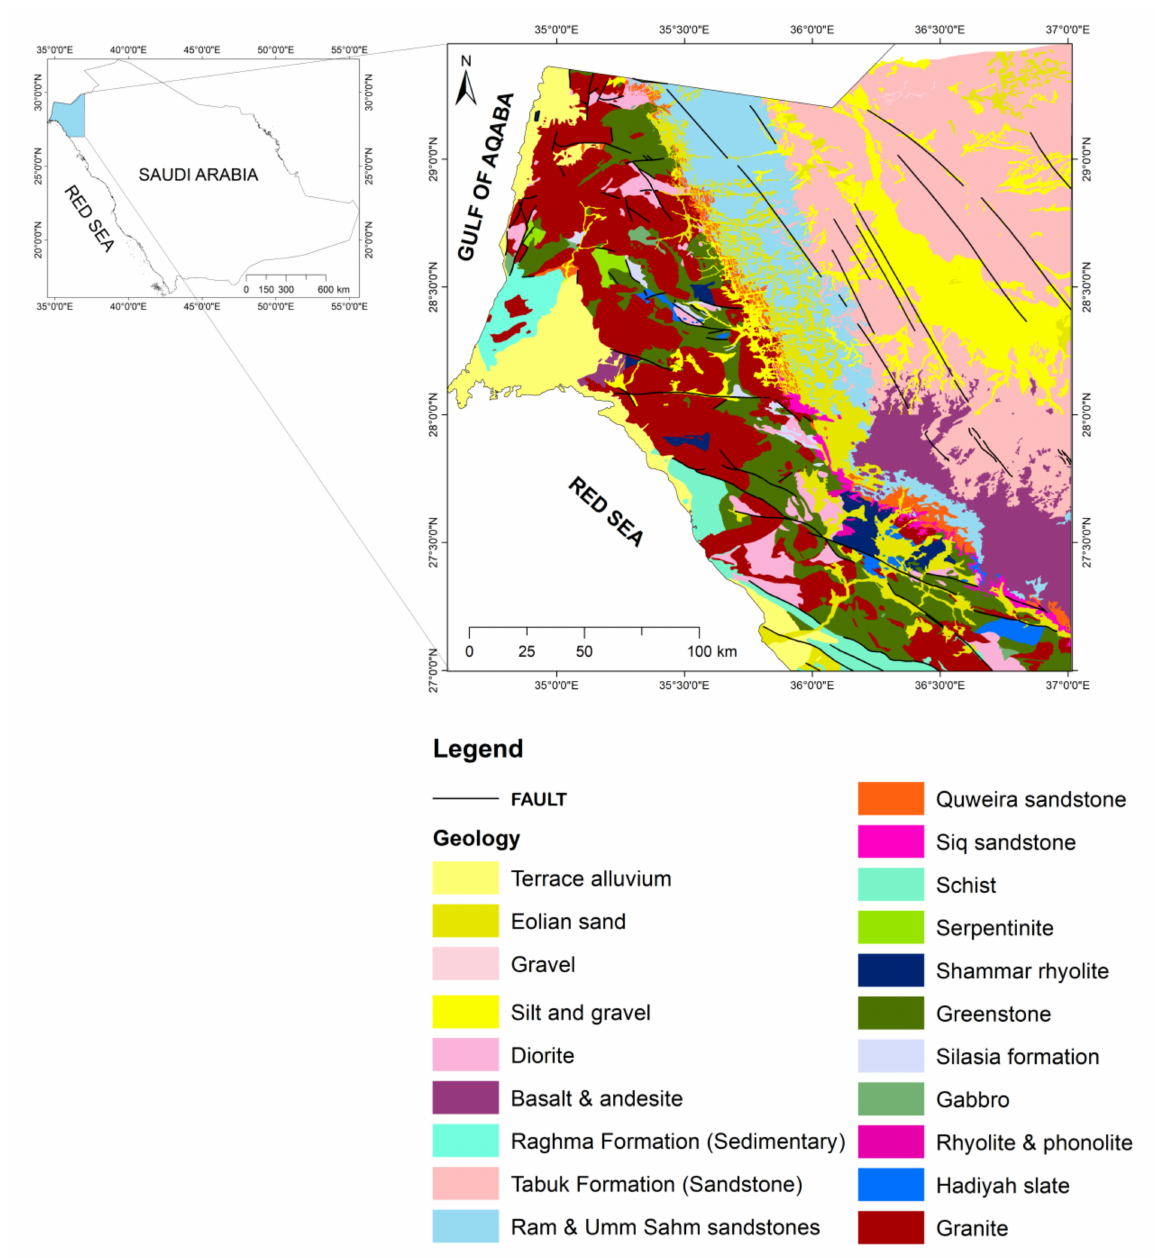
Figure 1. Geological map of Midyan Terrane showing the distribution of massive granites and other different rock units (after Faisal et al.